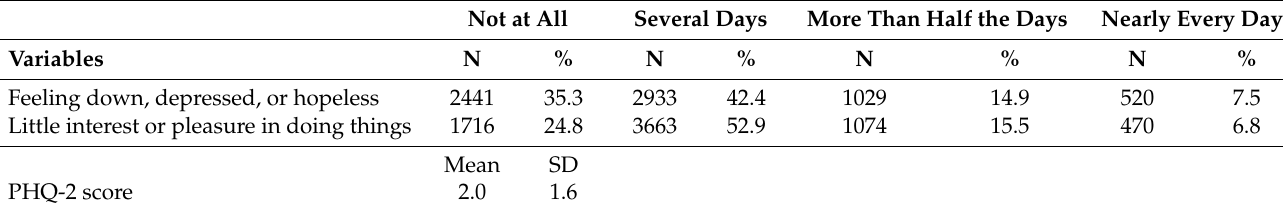
Table 3. Depressive symptoms assessed with the PHQ-2 ( n = 6918).